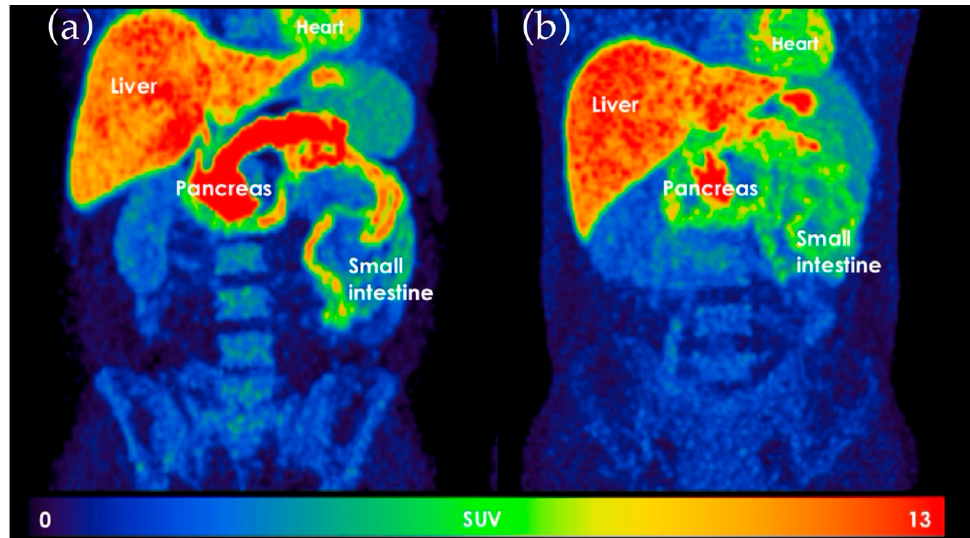
Figure 5. 11 C-donepezil positron emission tomography images. ( a ) Healthy control. ( b ) Patient with diabetes mellitus. Notice the difference in the standard value uptake in the pancreas and the small intestine. The picture is used with per- mission from Klinge, et al. 2020. intestine. The picture is used with permission from Klinge, et al.,